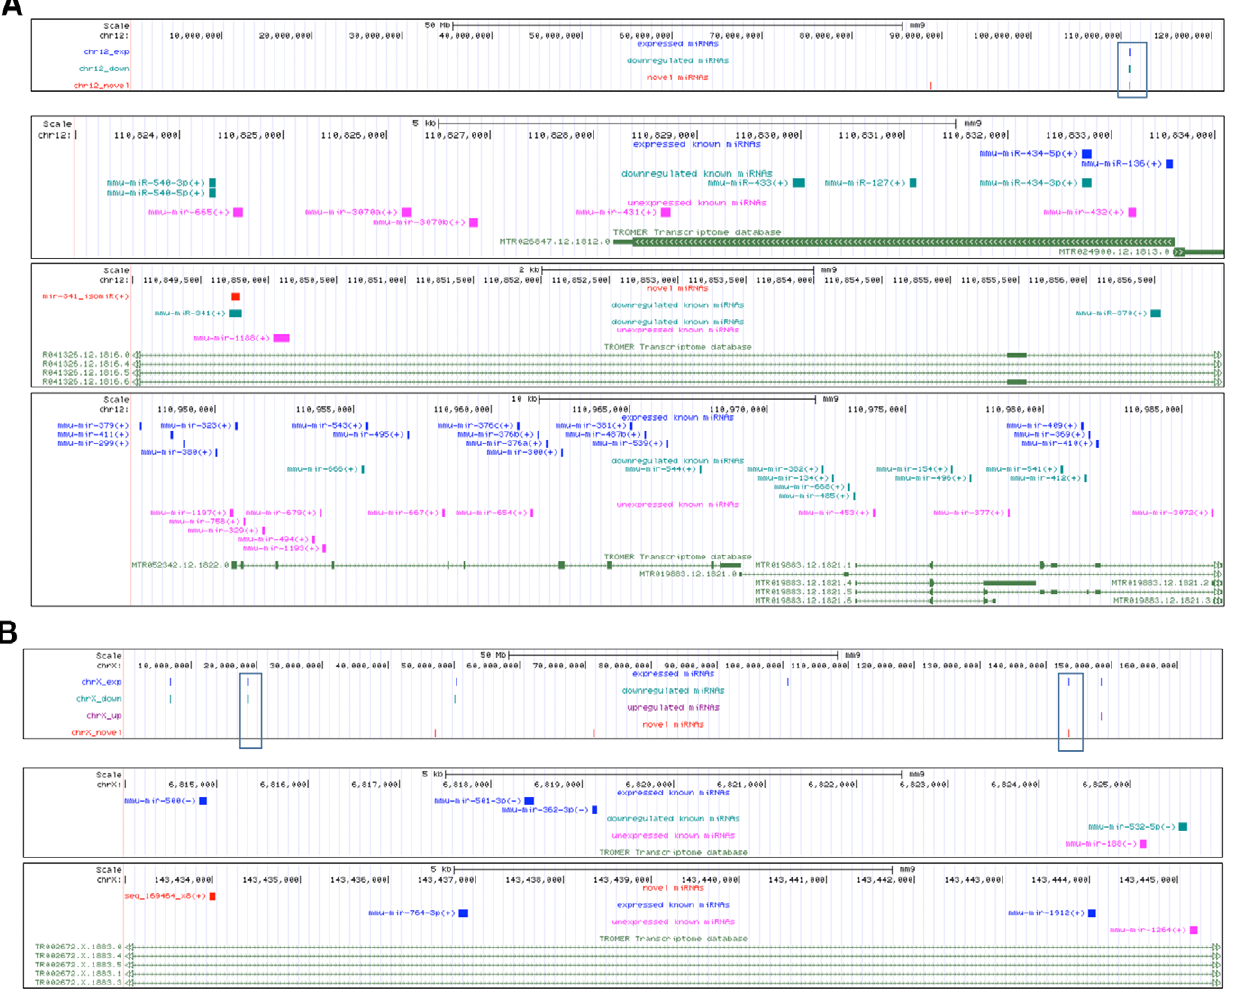
Figure 2. Genomic locations of brain-expressed miRNAs found within 10 kb region of each other. (a) miRNA clusters found on chromosome 12. Top panel: location of miRNAs relative to the entire chromosome 12. Bottom three panels: three distinct clusters found in the boxed off region in the top panel. The three clusters are located close to each other. (b) miRNA clusters found on X chromosome. Top panel: location of miRNAs relative to the entire X chromosome. Bottom two panels: clusters found in the boxed off regions of the top panel, from left to right. Blue: brain-expressed known miRNAs. Teal: miRNAs downregulated in expression in our dataset. Purple: miRNAs upregulated in expression in our dataset. Pink: known miRNAs found in the same genomic region but not found to be expressed in our dataset. Red: brain-expressed novel miRNA candidates. Green: TROMER transcriptome data (retrieved from UCSC Genome Browser).